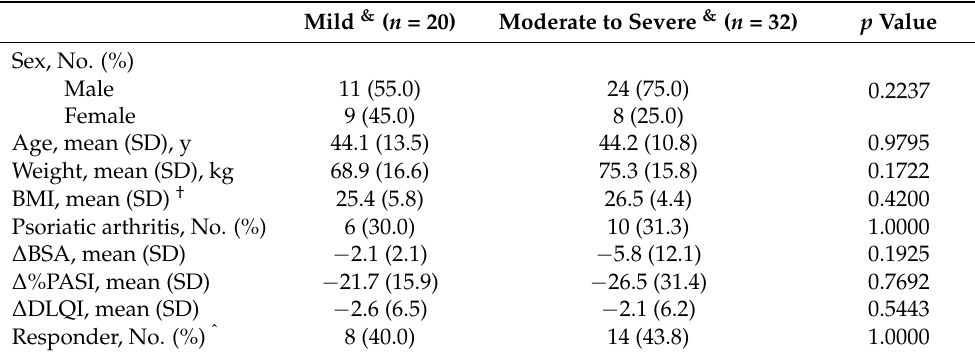
Figure 3. Pilot study of 8-week probiotics in psoriasis group ( A ) Study fl ow diagram. ( B ) Boxplot of the Dermatology Life Quality Index (DLQI) of the participants. ( C ) Change in Psoriasis Area and Severity Index (PASI) of the participants. ( D , E ) Boxplot of center-log-ratio (clr) transformed abundance of Lactobacillus plantarum and Parabacteroides distasonis ; Lactobacillus and Parabacteroides (Wilcoxon signed rank). Table 3. Demographic and disease characteristics of psoriatic participants.